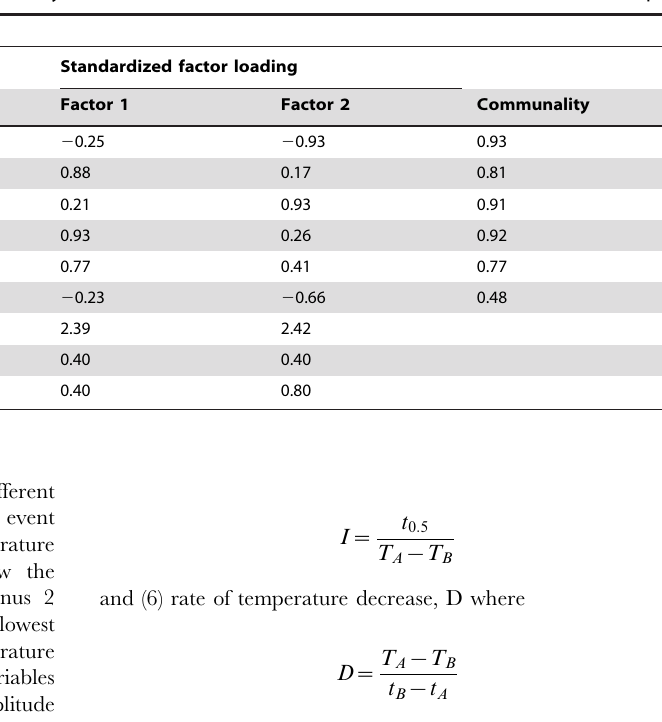
Table 3. Factor matrix from varimax-rotated component analysis on PDER events ( n =1267) recorded in nursed harbour seal pups.